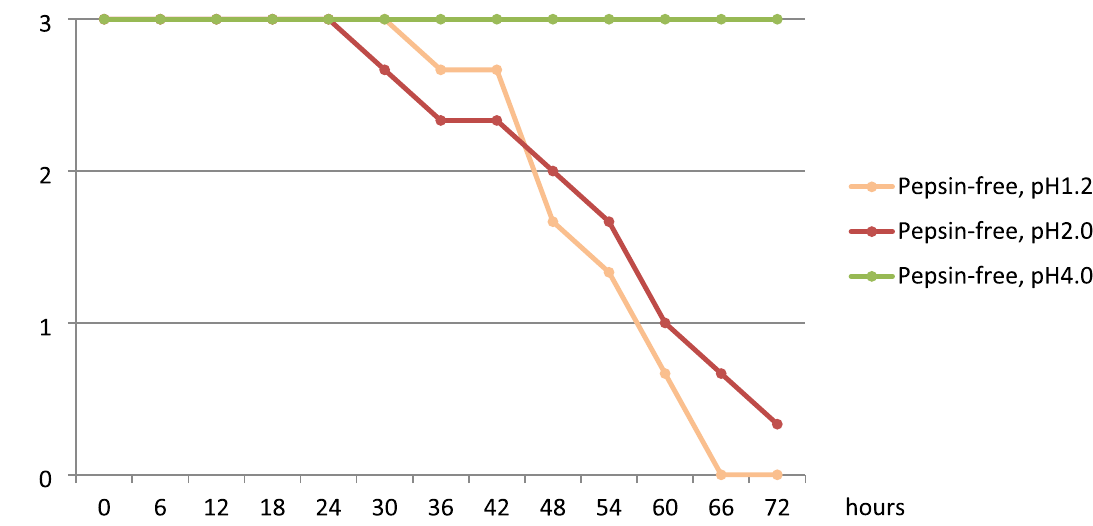
Figure 6. Change in the mean number of the remaining layers in the pH 1.2, pH 2.0, and pH 4.0 pepsin-free groups over time (N =